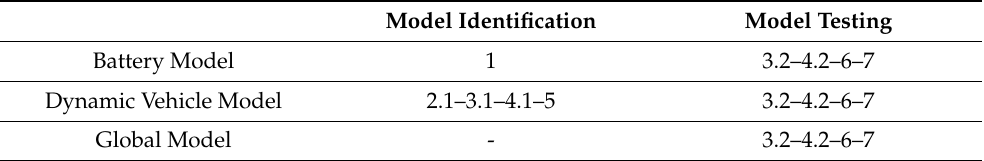
Table 4. Used Datasets for model identification and testing, with reference to Table